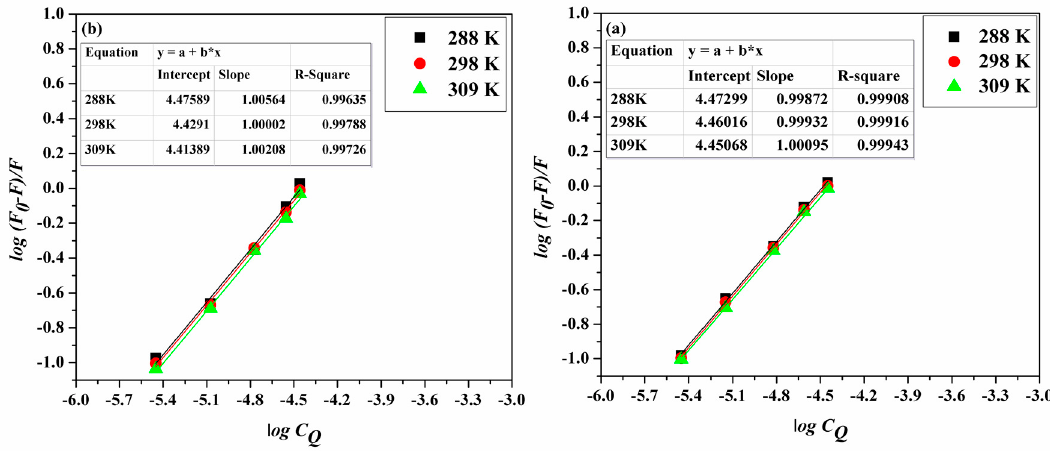
Figure 4. The double log plots for ( a ) ACV-HSA and ( b ) PNV-HSA systems at the studied temperatures.